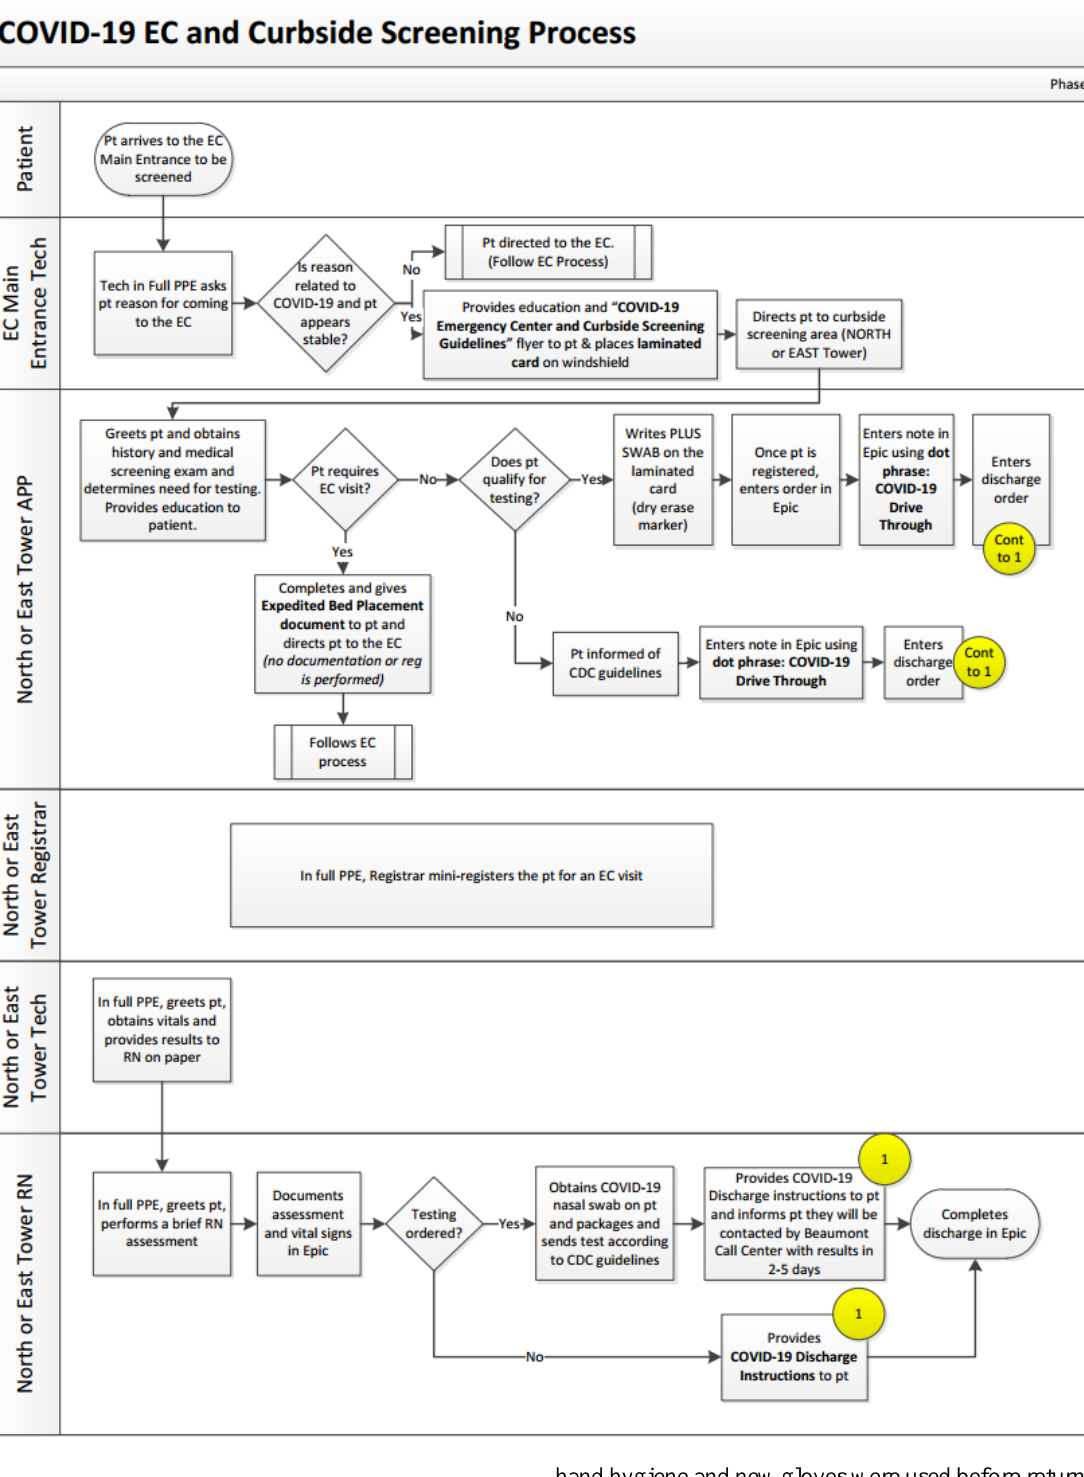
Figure 1. Layout of the emergency center curbside screening process at Beaumont Hospital in Royal Oak, MI. EC: emergency center; CDC: Centers for Disease Control and Prevention; PPE: personal protective equipment; COVID-19: coronavirus disease; APP: advanced practice provider; RN: registered